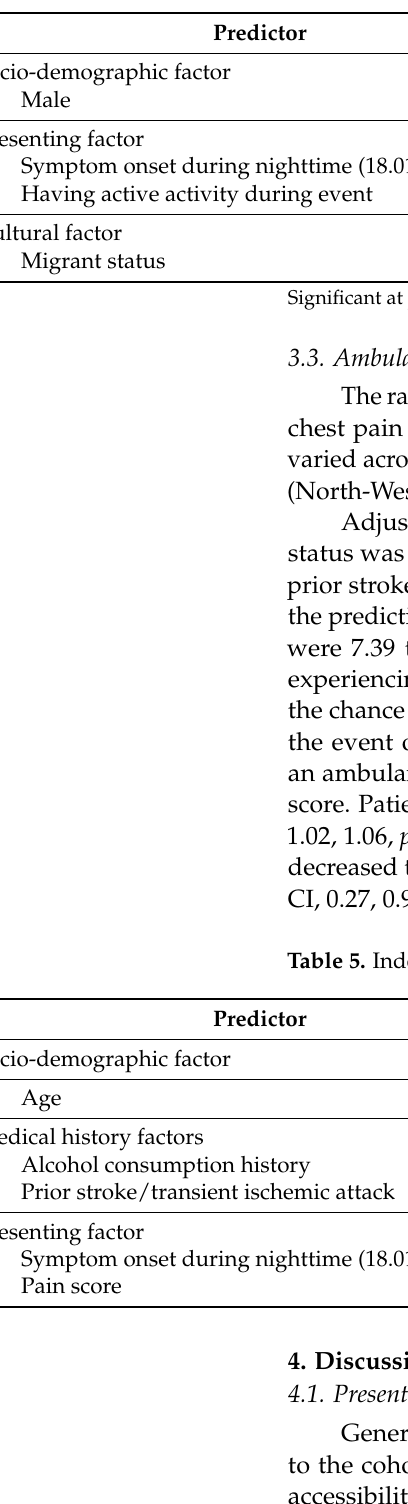
Table 4. Independent predictors of decision time within 1 h.